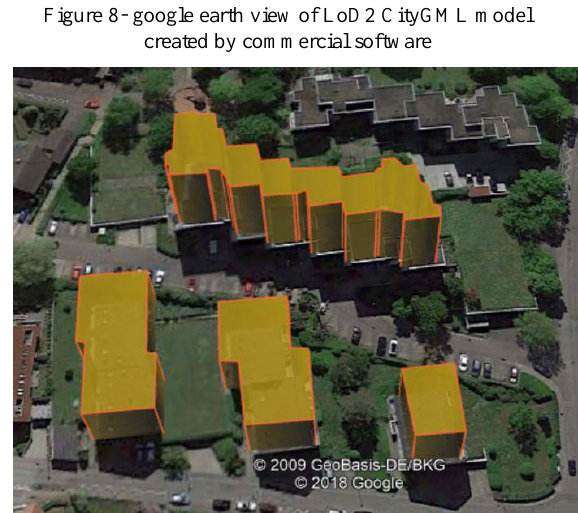
Figure 8- google earth view of LoD2 CityGML model created by commercial software